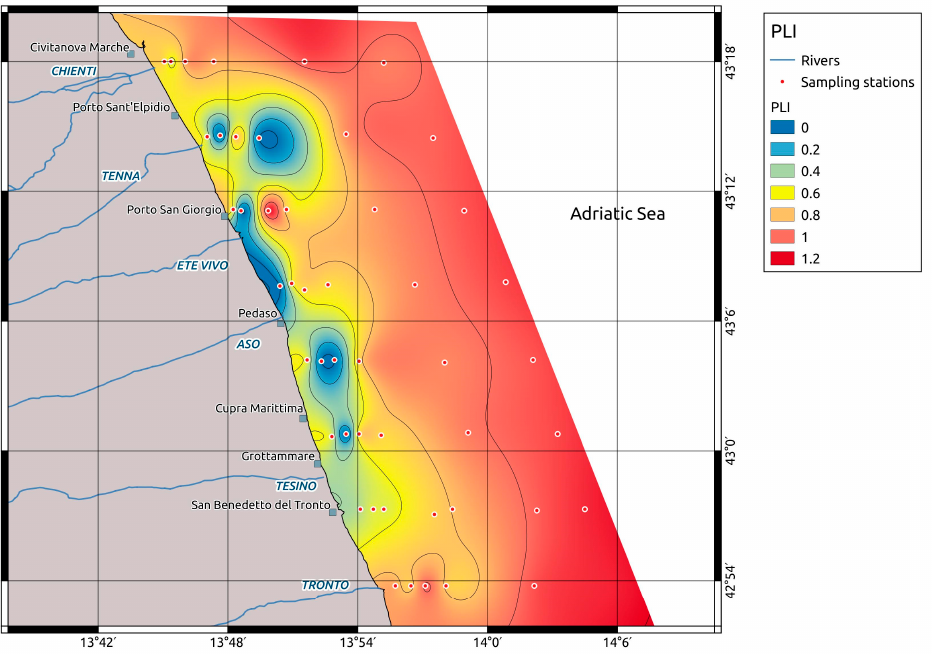
Figure 9. Areal distribution of the PLI values.